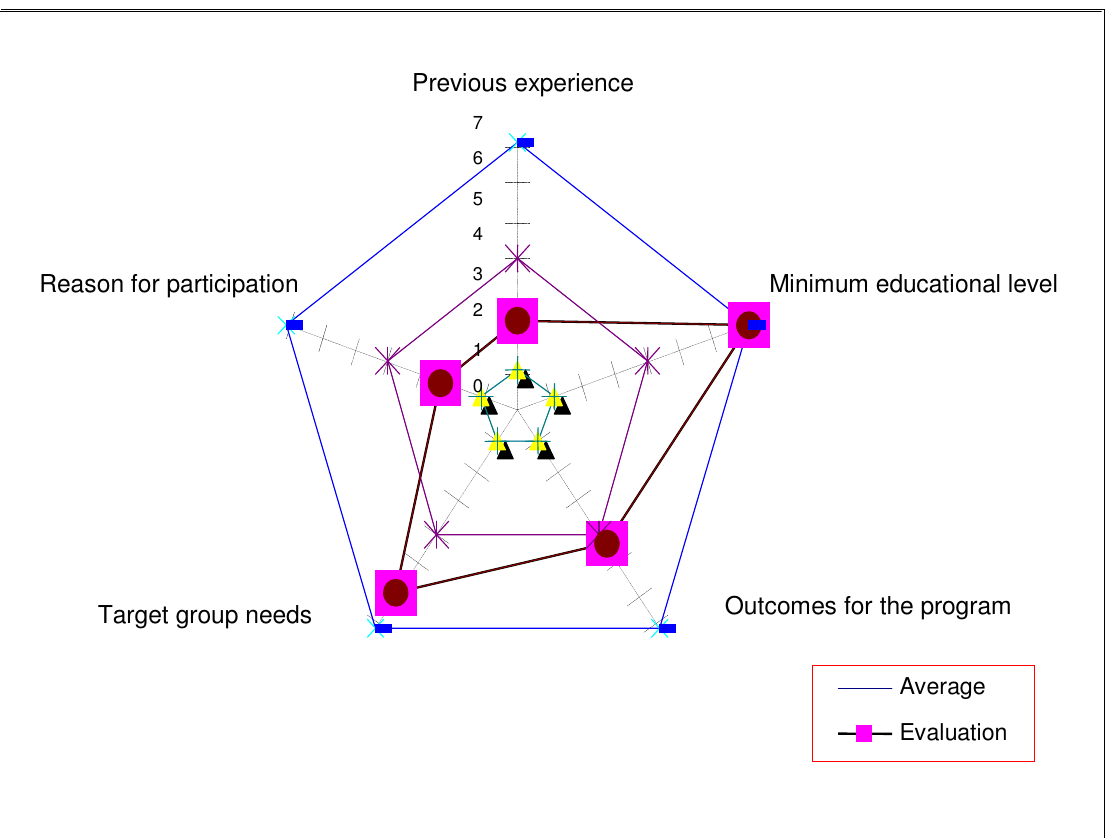
Figure 2: Assessment results for the context